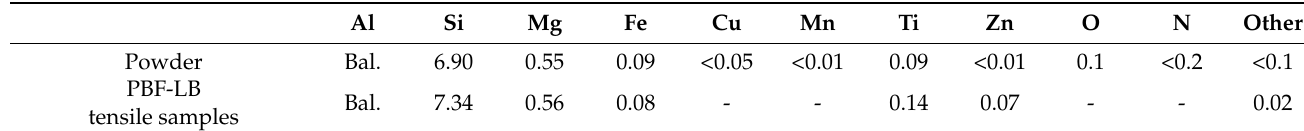
Table 1. The powder’s chemical composition (wt.%), given by the supplier [29], and PBF-LB tensile samples were checked by GDOES.